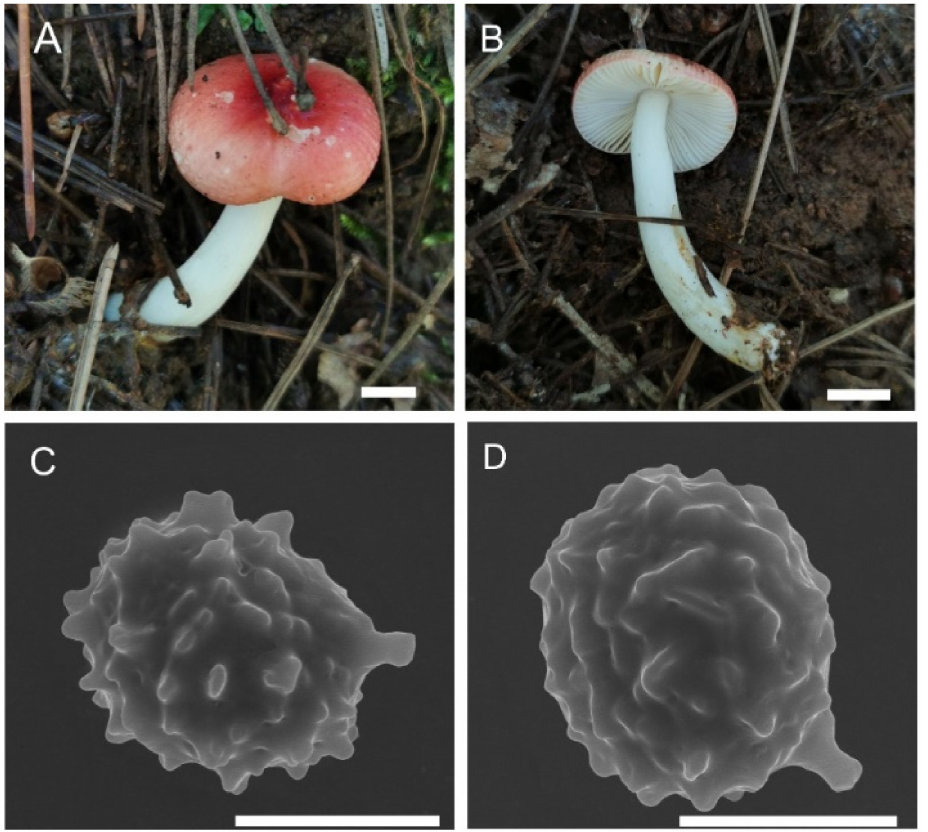
Figure 11. Russula sinoparva (BJTC ZH441). ( A , B ) Basidiomata. ( C , D ) Basidiospores. Scale bar: ( A , B ) = 10 mm, ( C , D ) = 5 µ